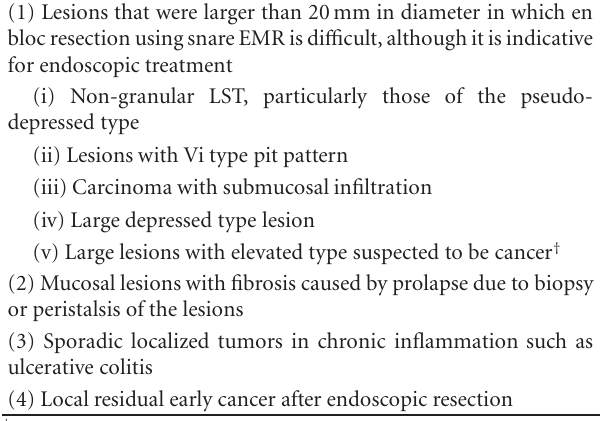
Table 3: Indication of endoscopic submucosal dissection (ESD) for colorectal